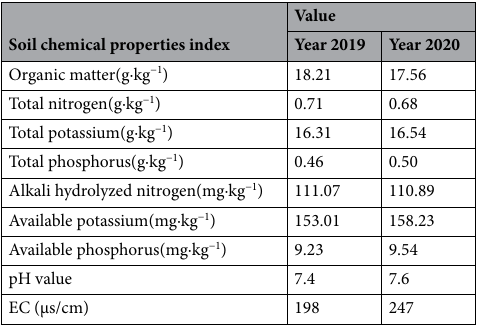
Table 1. The chemical properties of soil in the experimental site of 0-20 cm.